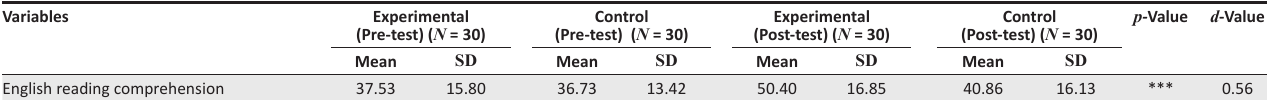
English reading